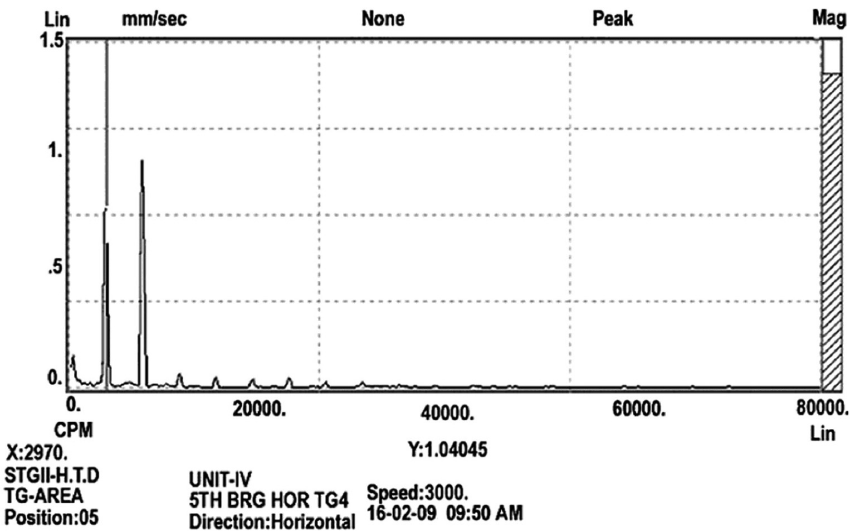
Fig. 3. Vibration spectrum that shows the maximum amplitude at high of